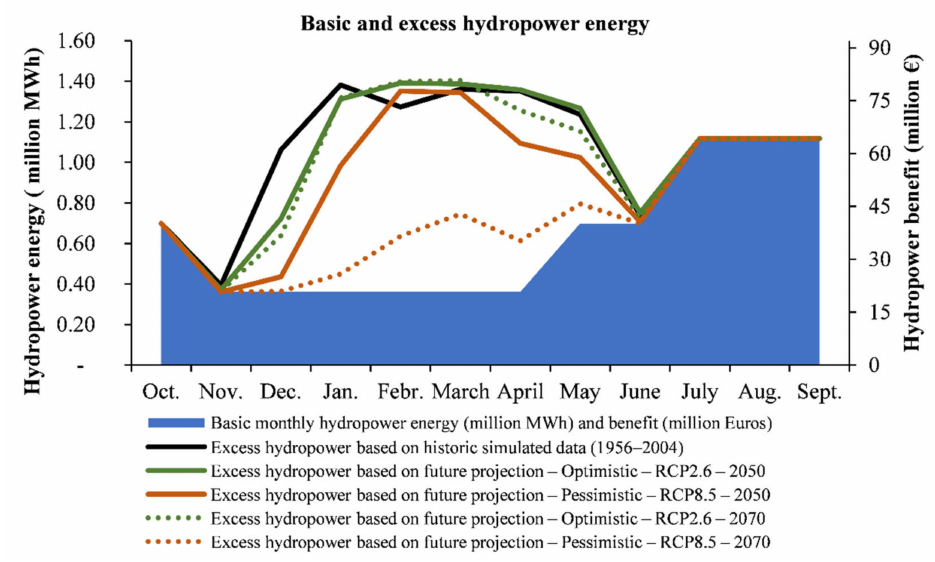
Figure 7. Basic and excess mean monthly hydropower energy production (million MWh) and corresponding probable benefit (million €